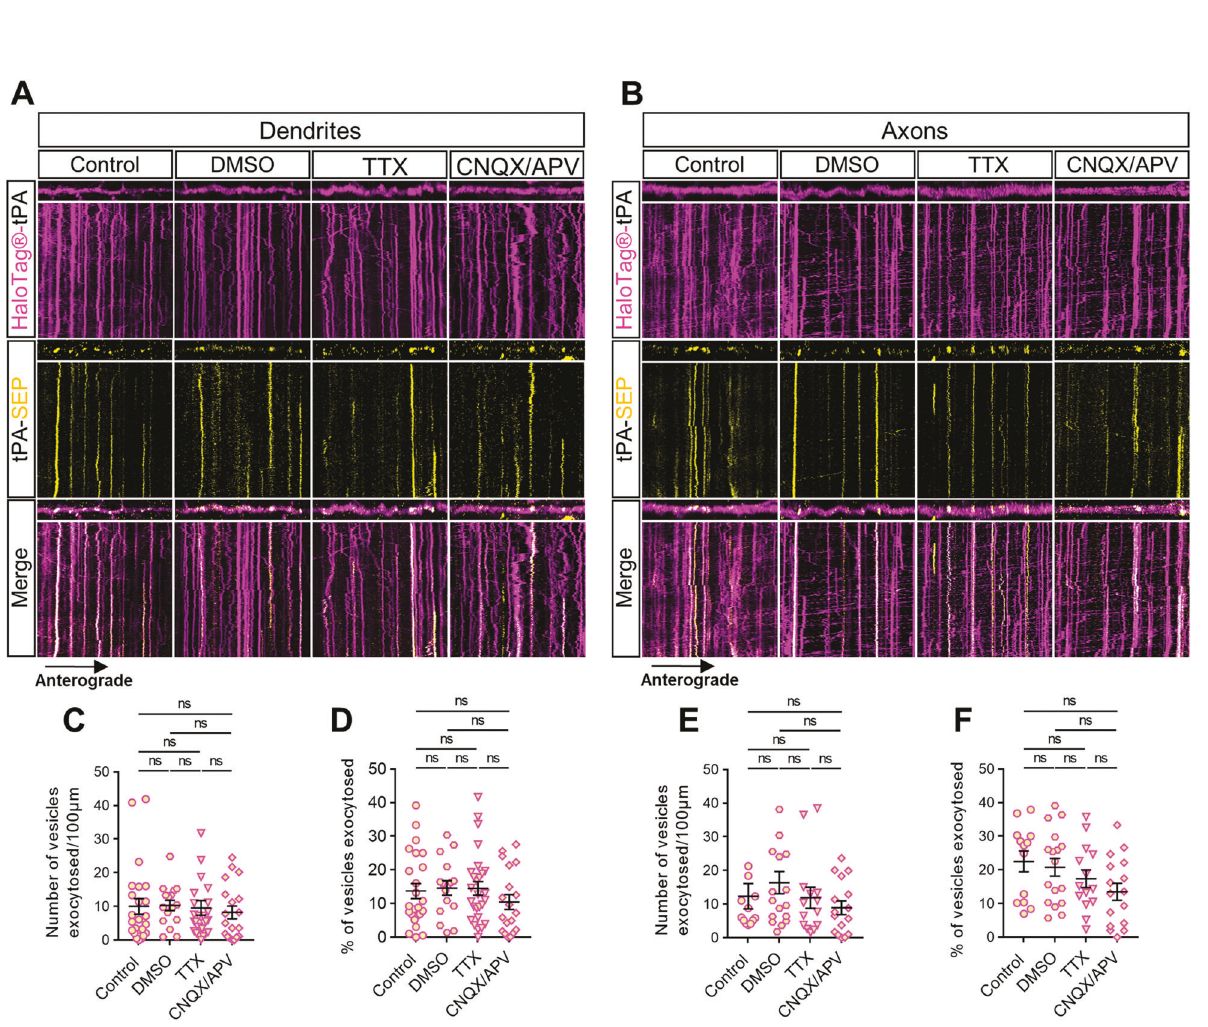
Fig. 3 Neuronal activation increases exocytosis of tPA-containing vesicles. A Schematic diagrams of a dual color reporter for neuronal tPA. The halotag ® allows highlighting the total pool of vesicles containing tPA, while the superecliptic pHluorin (SEP) allows observing exocytosis of vesicles, as well as the extracellular pool of tPA. B Graphic showing fl uorescence pro fi les of TMR-HaloTag ® and SEP before (1) and after (2) a tPA exocytosis, corresponding to the two situations in the schematic representation in ( A ). C , D Example of a dendritic tPA exocytosis in C (MAP2 positive process; in cyan) and of an axonal tPA exocytosis in ( D ) (MAP2 negative process) in basal conditions. At the top, a representative z-stack of confocal images of transfected cortical neurons (DIV13) with pCMV_HaloTag ® -tPA-SEP plasmid (TMR ligand; in magenta and SEP; in yellow), a fi rst zoom on the observed process, and a second zoom on the vesicle followed just below (white arrow). At the bottom, time-lapse images were acquired in 2 dimensions every 30 s (t = 0 was assigned of exocytosis; Time is in min:sec), nearby respective kymographs of HaloTag ® -tPA-SEP exocytosis are shown. E , F Representative stacks of processes time lapse and their associated kymographs displaying HaloTag ® -tPA-SEP during neuronal activation with Bic/Gly (30 µM/200 µM) and KCl (50 mM) treatments in dendrites ( E ) and in axons ( F ). All processes shown in ( E , F ) measures 40 µm, and all kymographs represent 40 µm horizontally and 10 min vertically. G Number of vesicles exocytosed per 100 µm in dendrites. Control n = 22, Bic/Gly n = 21, KCl n = 16 neurons. H Number of vesicles exocytosed (SEP positive) as the ratio of the total pool of tPA vesicles (TMR-HaloTag ® positives) on dendrites. Control n = 22, Bic/Gly n = 21, KCl n = 16 neurons ( G , H ) from 2 to 5 independent cultures. I Number of vesicles exocytosed per 100 µm in dendrites. Control n = 12, Bic/Gly n = 14, KCl n = 14 neurons. J Number of vesicles exocytosed (SEP positive) as the ratio of the total pool of tPA vesicles (TMR-HaloTag ® positives) on axons. Control n = 12, Bic/Gly n = 14, KCl n = 14 neurons ( G , H ) from 2 to 5 independent cultures. G , H , I , J one-way ANOVA and a Tukey ’ s post hoc tests were used.